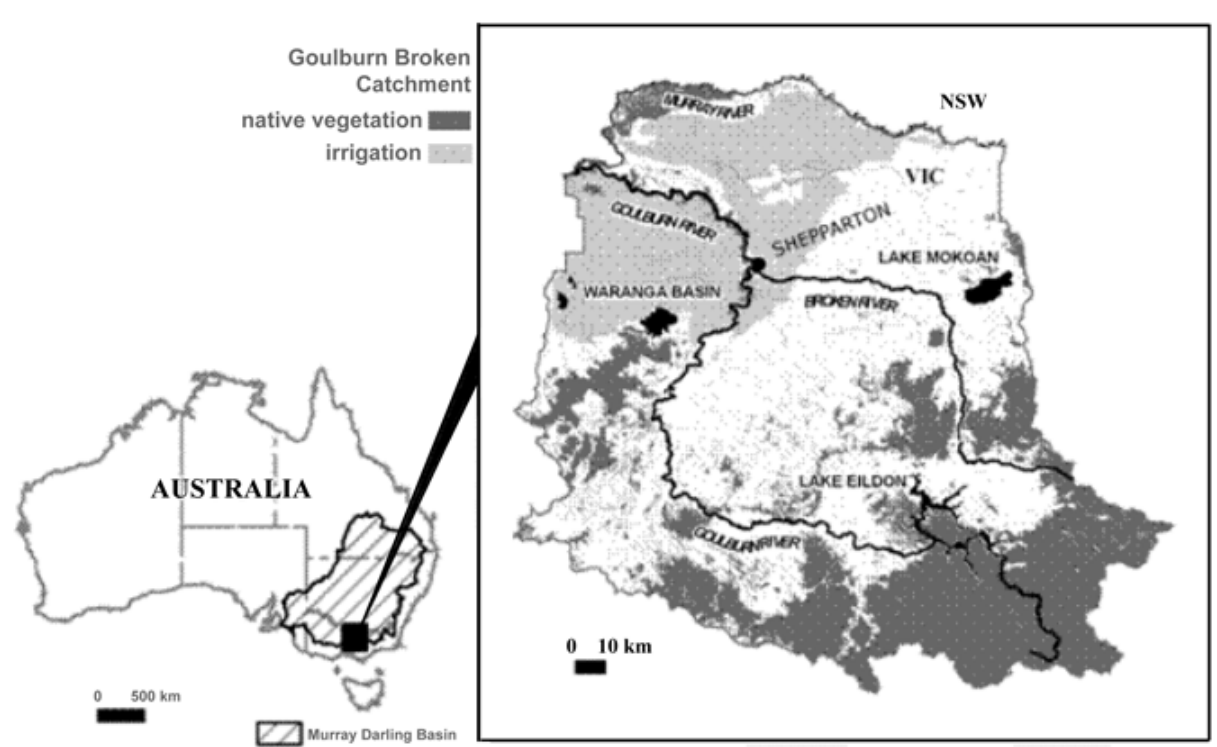
Fig. 1. Location of the Goulburn-Broken Catchment and